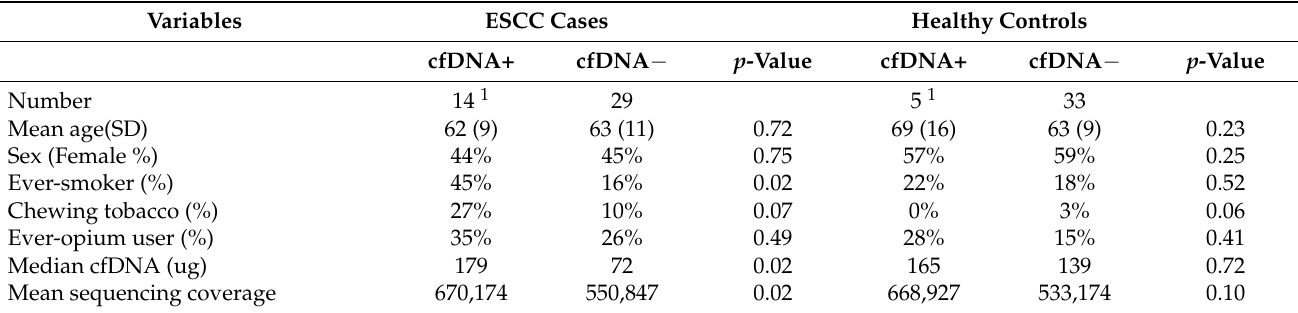
Table 1. Characteristics of cases and controls with and without concordant TP53 cfDNA variants, comparing TP53 mutations in FFPE tumor